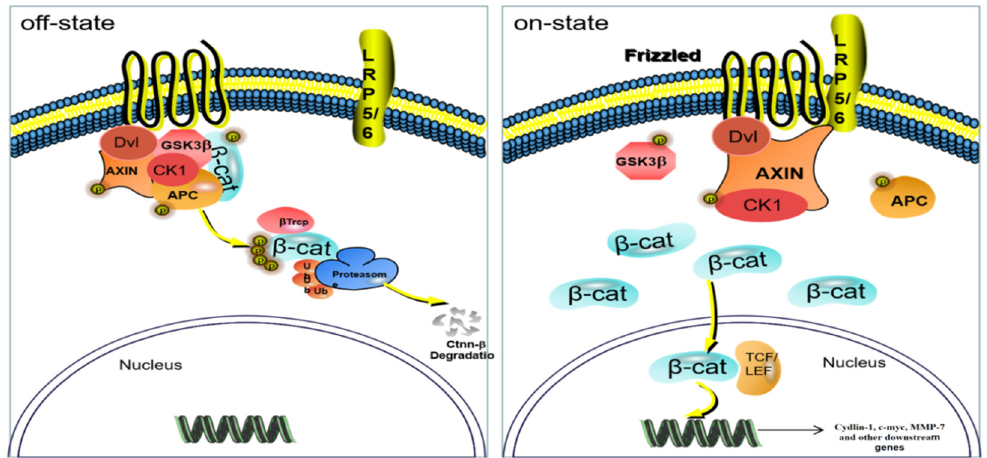
Figure 17. Wnt/ β -catenin signaling